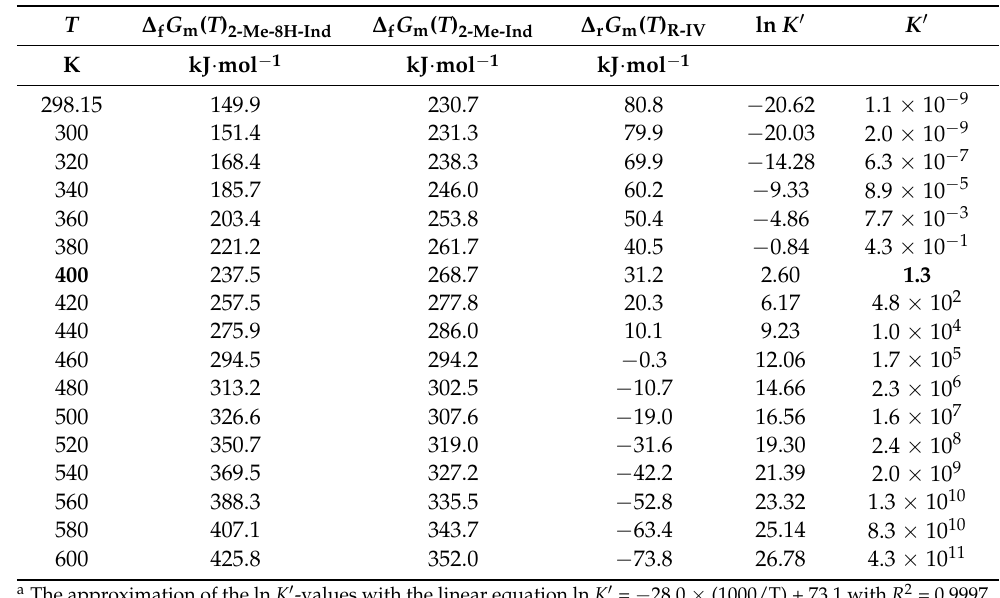
Table 15. Gas-phase standard molar Gibbs energies of 2-methyl-8H-indole and 2-methyl-indole and thermodynamic parameters of the dehydrogenation reaction R-IV at p ◦ = 2.0 MPa a .